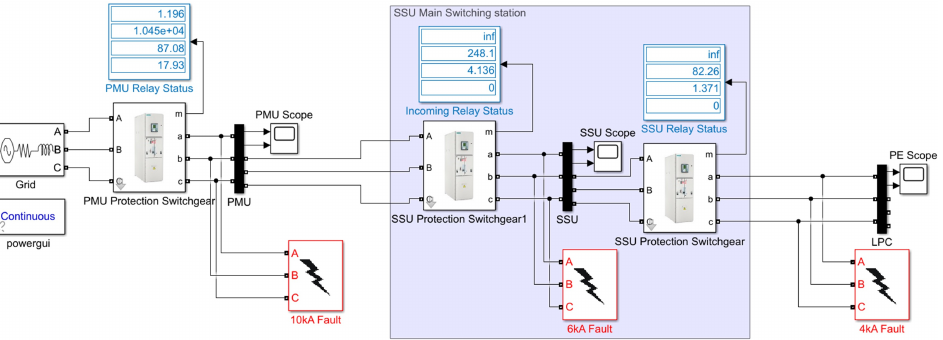
Figure 1. Instantaneous overcurrent relay block